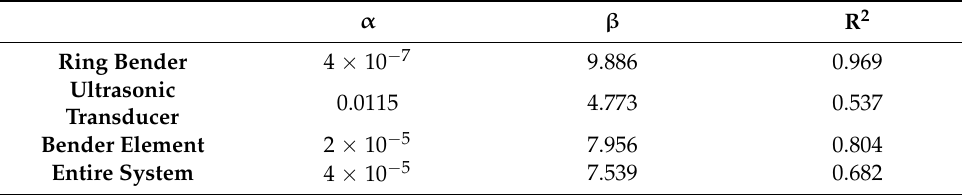
Figure 14. Relationship between water content and maximum shear modulus.